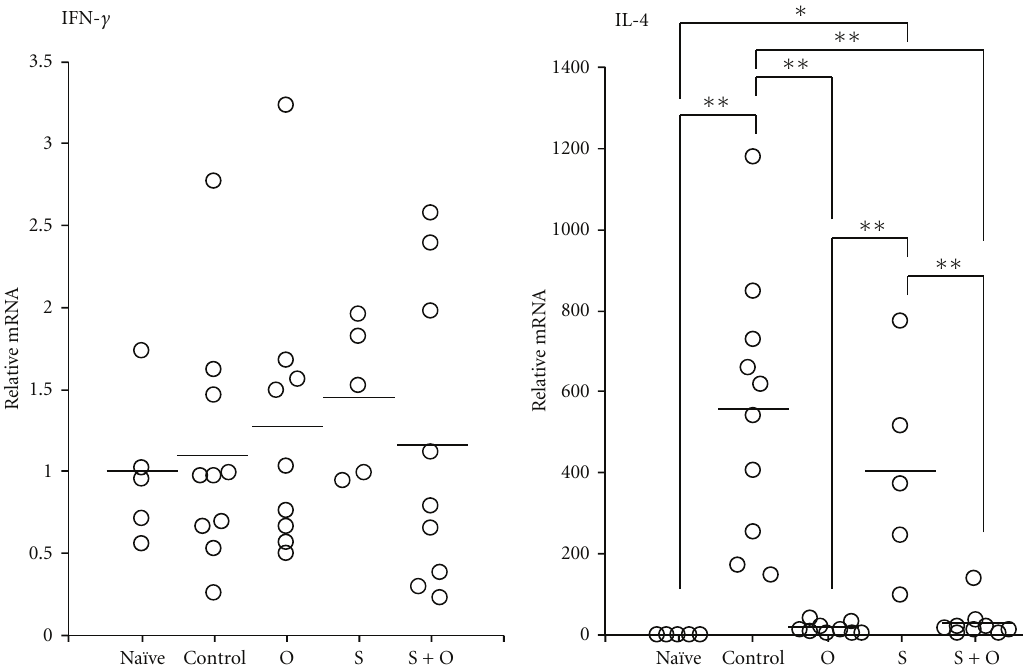
Figure 4: E ff ects of the maternal exposure to food antigens during lactation and the maternal allergic status on Th1 and Th2 cytokine profiles in the proximal colons of o ff spring with FA. The mRNA expression levels of IL-4 were completely reduced to the na¨ıve mice range in o ff spring breastfed by OVA-exposed mothers during lactation, but IFN- γ mRNA expression levels were not altered by the maternal exposure to food antigens and the maternal allergic status. Data are shown as the means and individual data points. ∗ P < 0 . 05, ∗∗ P < 0 . 01, n =